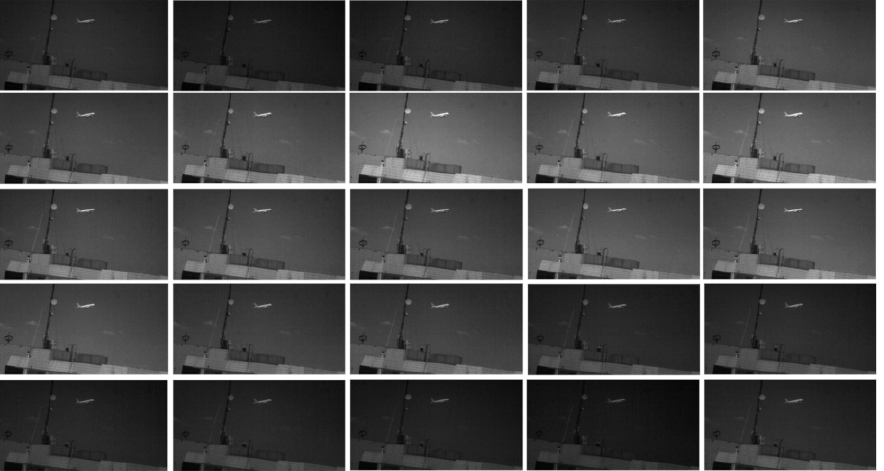
Figure 11. Illustration of a set of 25 bands of HSI. The 25 bands are ordered in ascending from left to right and top and bottom, and its center wavelengths are 682.27 nm, 696.83 nm, 721.13 nm, 735.04 nm, 747.12 nm, 760.76 nm, 772.28 nm, 784.81 nm, 796.46 nm, 808.64 nm, 827.73 nm, 839.48 nm, 849.40 nm, 860.49 nm, 870.95 nm, 881.21 nm, 889.97 nm, 898.79 nm, 913.30 nm, 921.13 nm, 929.13 nm, 936.64 nm, 944.55 nm, 950.50 nm, 957.04 nm, respectively.